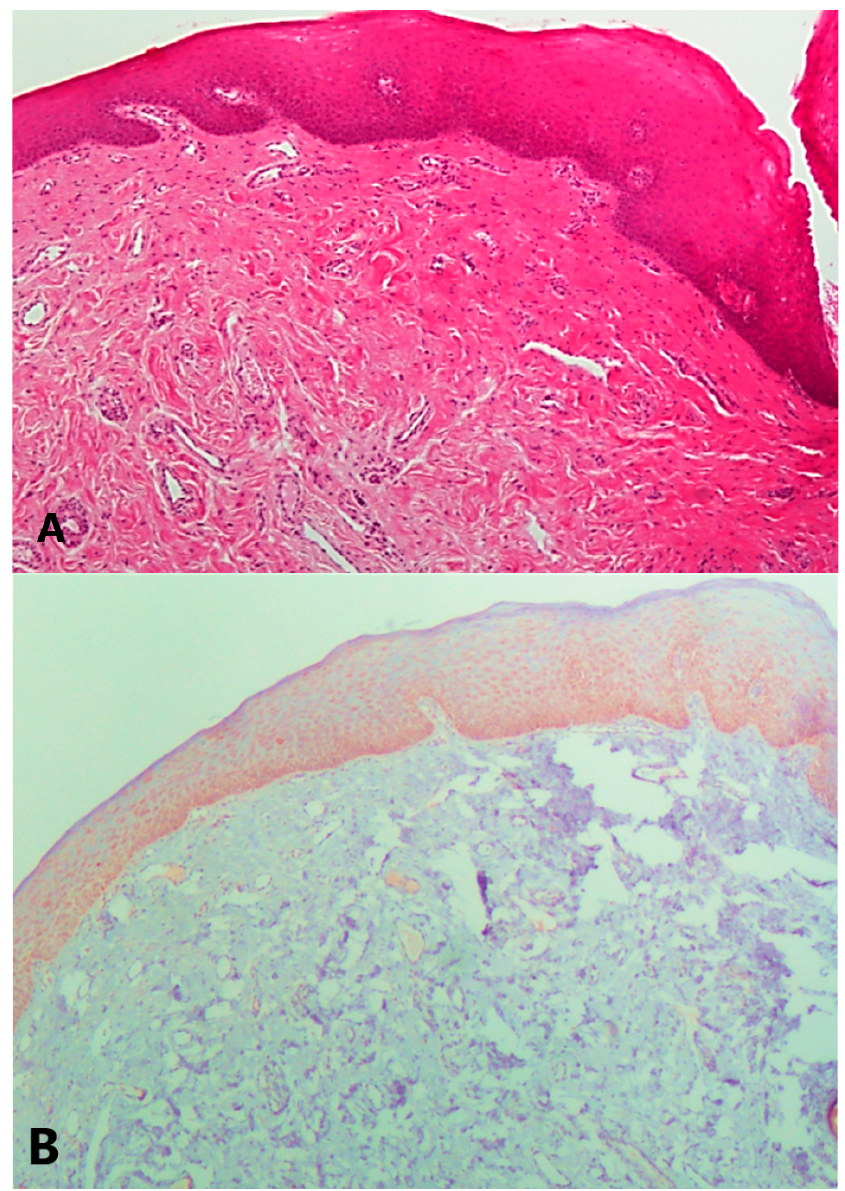
Figure 3. ( A ): Fibrous hyperplasia of the oral mucosa: Dense fibrous connective tissue lined by hyperkeratotic oral epithelium (H&E magnification ×100). ( B ): fibrous hyperplasia of the oral mucosa, Diffuse cytoplasmic VDAC1 staining in the epithelium. (VDAC1 magnification ×100).